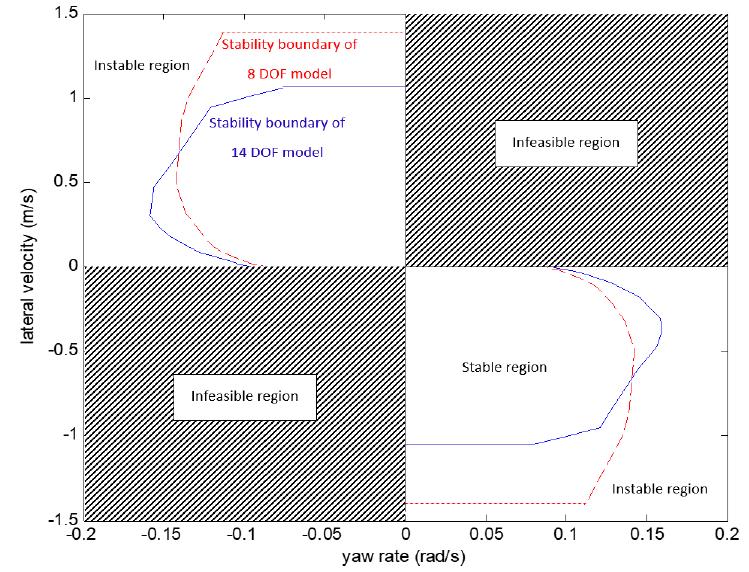
Figure 6. Compares the yaw-plane stability region of 14 DOF model and 8 DOF model ( 𝑣 (cid:3051) = 40, 𝜇 = 1